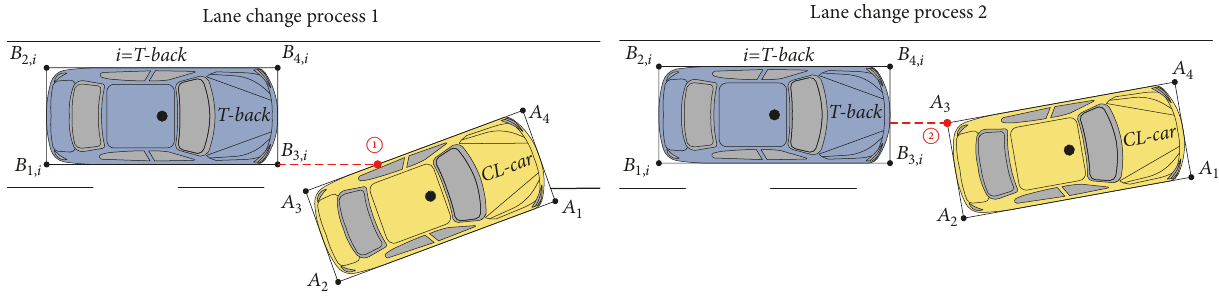
Figure 10: Potential angle collision point positions in different lane change processes between CL-car and T-back .